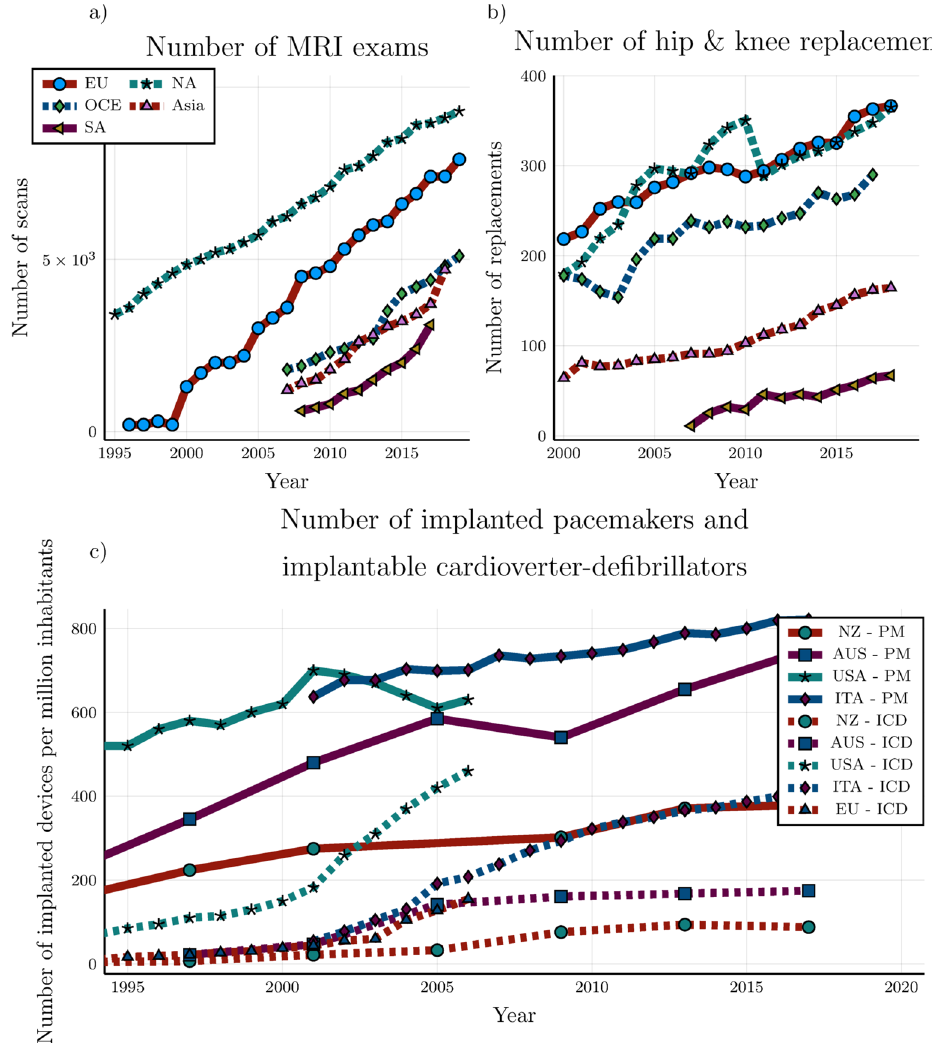
Figure 1. ( a ) The number of MRI scans performed per 100.000 inhabitants. ( b ) The number of hip and knee replacements per 100.000 inhabitants. Data presented for the 21 indicated countries (OECD (2021), Magnetic resonance imaging (MRI) exams (indicator). https://data.oecd.org/healthcare/magnetic-resonance-imaging- mri-exams.htm (Accessed on 01 August 2021)). ( c ) The number of implanted pacemakers (PM) and implantable cardioverter-defibrillators (ICD) per 1 million inhabitants in the indicated countries 2–5